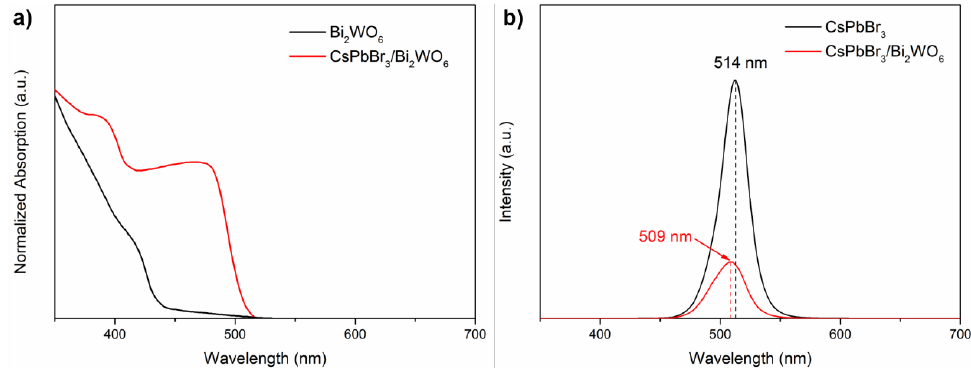
Figure 4. ( a ) UV-vis absorption spectra and ( b ) steady-state PL spectra of CsPbBr 3 and 15 wt% CsPbBr 3 /Bi 2 WO 6 .